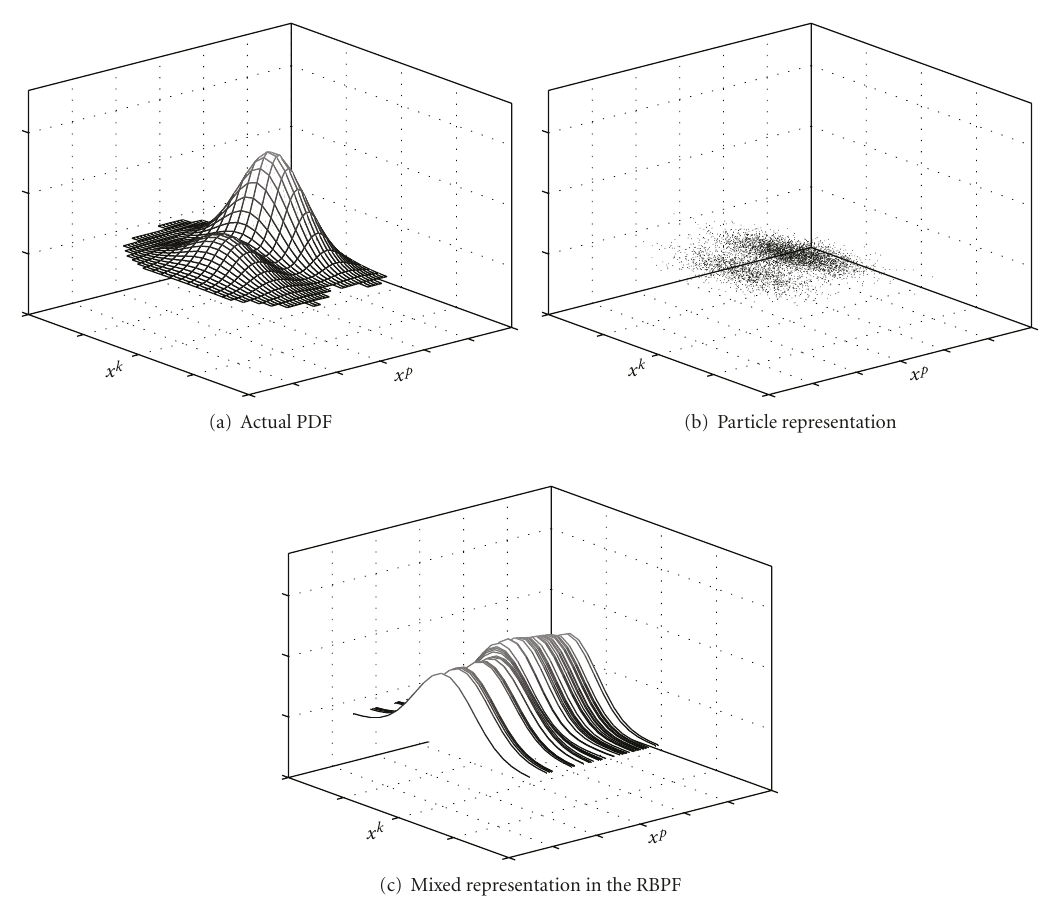
Figure 1: Illustration of the di ff erent state distribution representations. Note that 5000 particles are used for the particle representation, whereas only 50 were needed for an acceptable